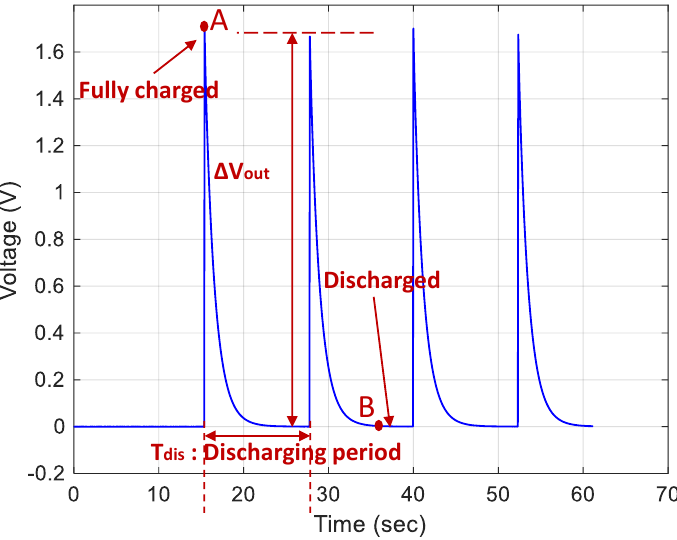
Figure 4. Discharging voltage versus time when LTC3588 is connected to the external load R load = 20 k Ω; Cin = 22 μ F; Cout = 47 μ F; and f = 2.88 Hz.